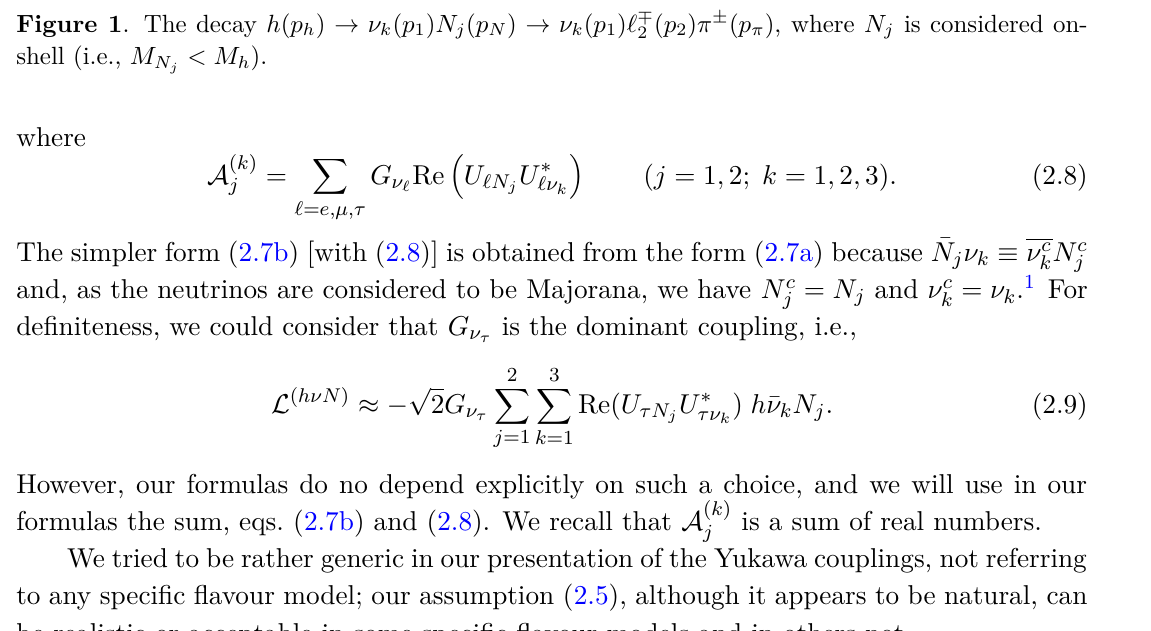
( p 2 ) π ± ( p π ) , where N j is considered on- 2